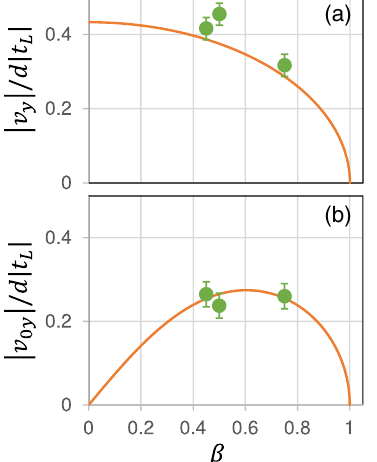
FIG. 4. Dirac cone tilt. Green dots: Absolute value of v v 0 (b) extracted from fits of Eq. (2) to the two experimental Dirac y cones visible at low energies in Figs. 3(b) – 3(d) (see Appendix C). The plotted value is the average of j v the two Dirac points. Solid lines show the tight-binding